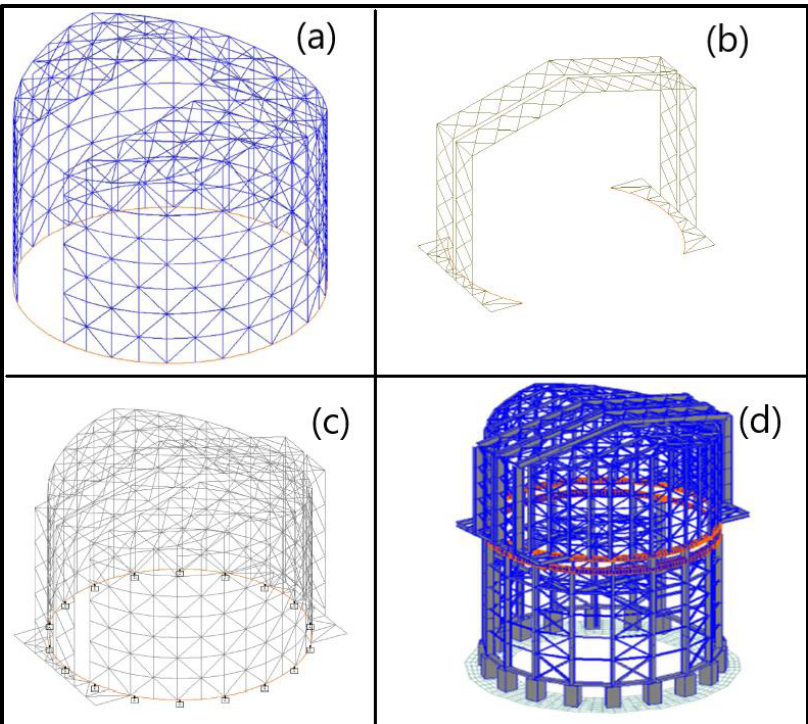
Figure 7. Geometry of (a) Dome (b) Slit doors (c) Slit doors in closed condition over dome with supporting wheels (d) Combination of dome building and